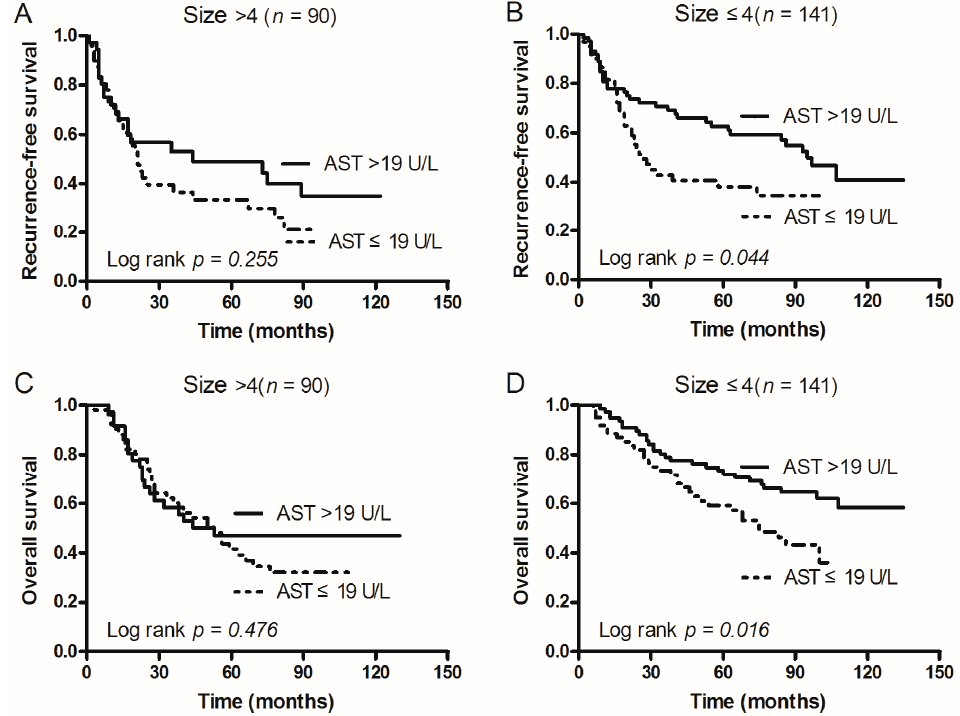
Figure 2. Kaplan–Meier survival curves of patients with AST > 19 U/L and AST ≤ 19 U/L grouped by patient tumor size. ( A ) In tumors size >4 cm patients, RFS of patients with AST ≤ 19 U/L was shorter than that of those with AST > 19 U/L ( p = 0.255); ( B ) In size ≤ 4 cm patients, RFS of patients with AST ≤ 19 U/L was shorter than that of those with AST > 19 U/L ( p = 0.044); ( C ) In size >4 cm patients, OS of patients with AST ≤ 19 U/L was shorter than that of those with AST > 19 U/L ( p = 0.476); ( D ) In size ≤ 4 cm patients, OS of patients with AST ≤ 19 U/L was shorter than that of those with AST > 19 U/L ( p =